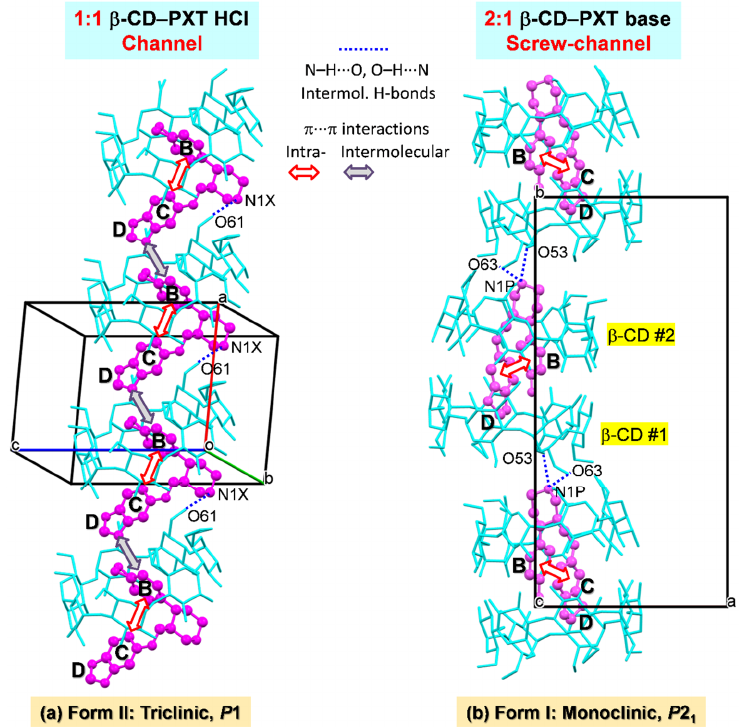
Figure 5. Elusive polymorphism of CD inclusion complexes demonstrated for ( a ) 1:1 β -CD–PXT HCl in triclinic, P 1 (form II) packing in the channel structure and ( b ) 2:1 β -CD–PXT base in monoclinic, P 2 1 (form I) existing in the screw-channel structure [35]. β -CD macrocycles and PXT molecules are shown with cyan wireframes and magenta ball-and-stick models, respectively. For better visibility, water molecules, chlorides and H-atoms are omitted. The crystal lattices are stabilized not only by O–H ··· O H-bonds within and between β -CDs, but also by the host–guest N–H ··· O, O–H ··· N H-bonds, intramolecular face-to-face π ··· π (form I) and edge-to-face intra-, intermolecular π ··· π and C–F ··· π interactions (form